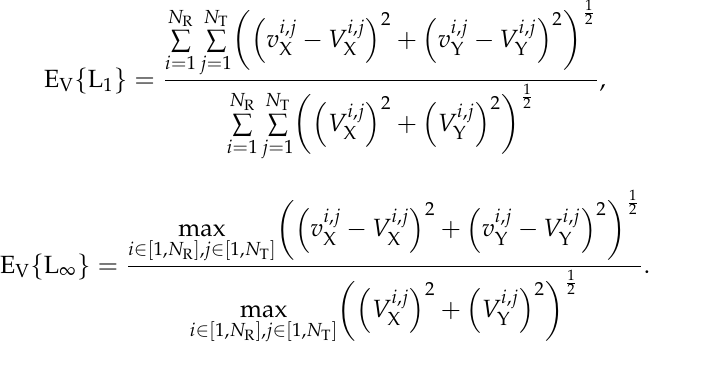
Figure 5. Two interconvertible problem statements, the receivers’ positions are marked with the diamonds, and the source position is marked with the asterisk: ( A ) with an overlapping curvilinear mesh, original coordinate system; ( B ) without an overlapping curvilinear mesh.